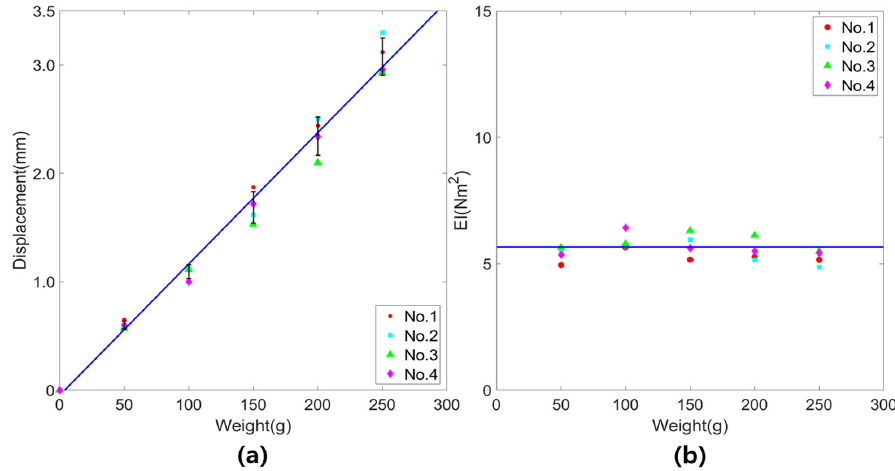
Figure 8. Static bending test results for TFR-8: ( a ) Free end displacement versus applied load (coefficient of determination: 0.996); ( b ) Equivalent flexural rigidity.